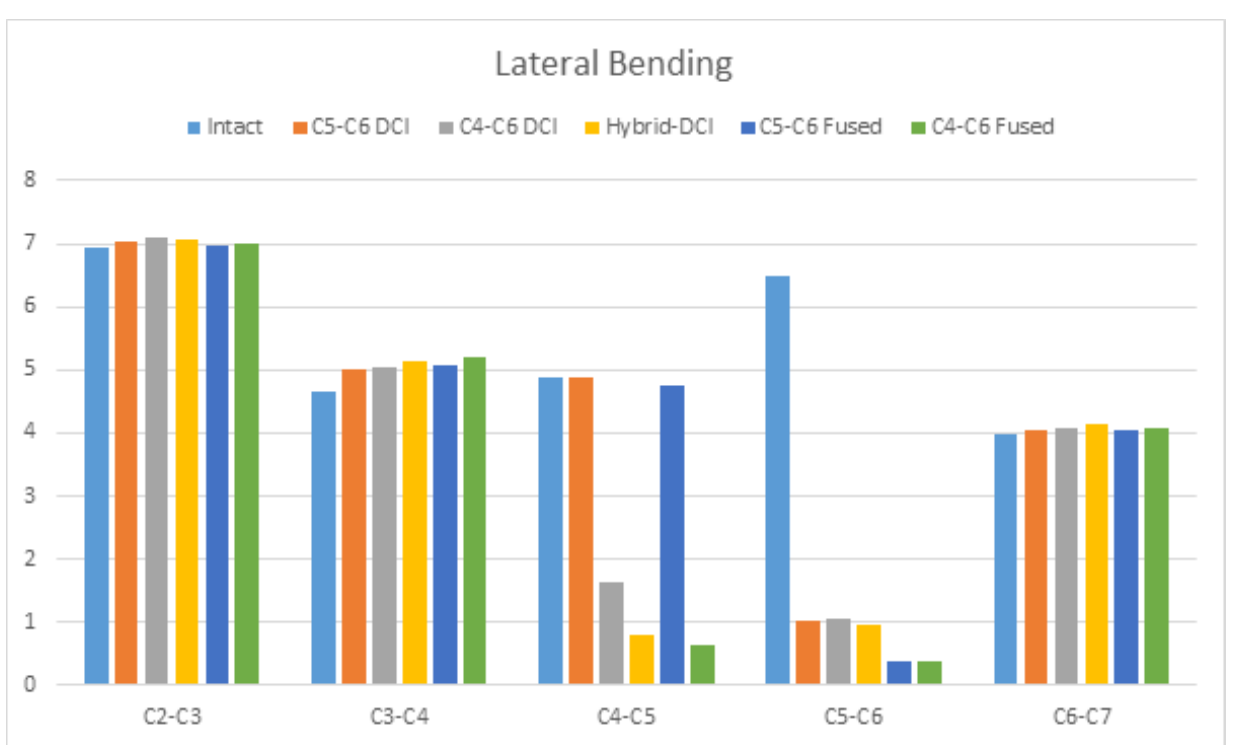
Figure 5. The comparison of ROMs during extension among the C5–C6 DCI, C4–C6 DCI, hybrid DCI, C5–C6 ‐ fused, and C4–C6 fused models. The vertical axis shows ROMs in degrees.